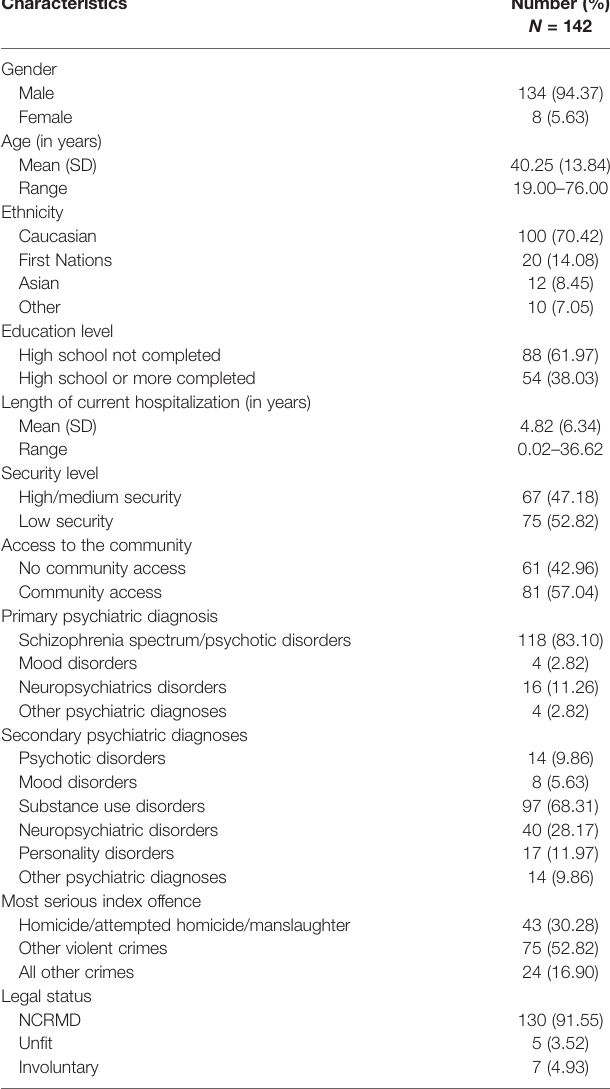
TABLE 1 | Demographic, clinical, and forensic characteristics of the